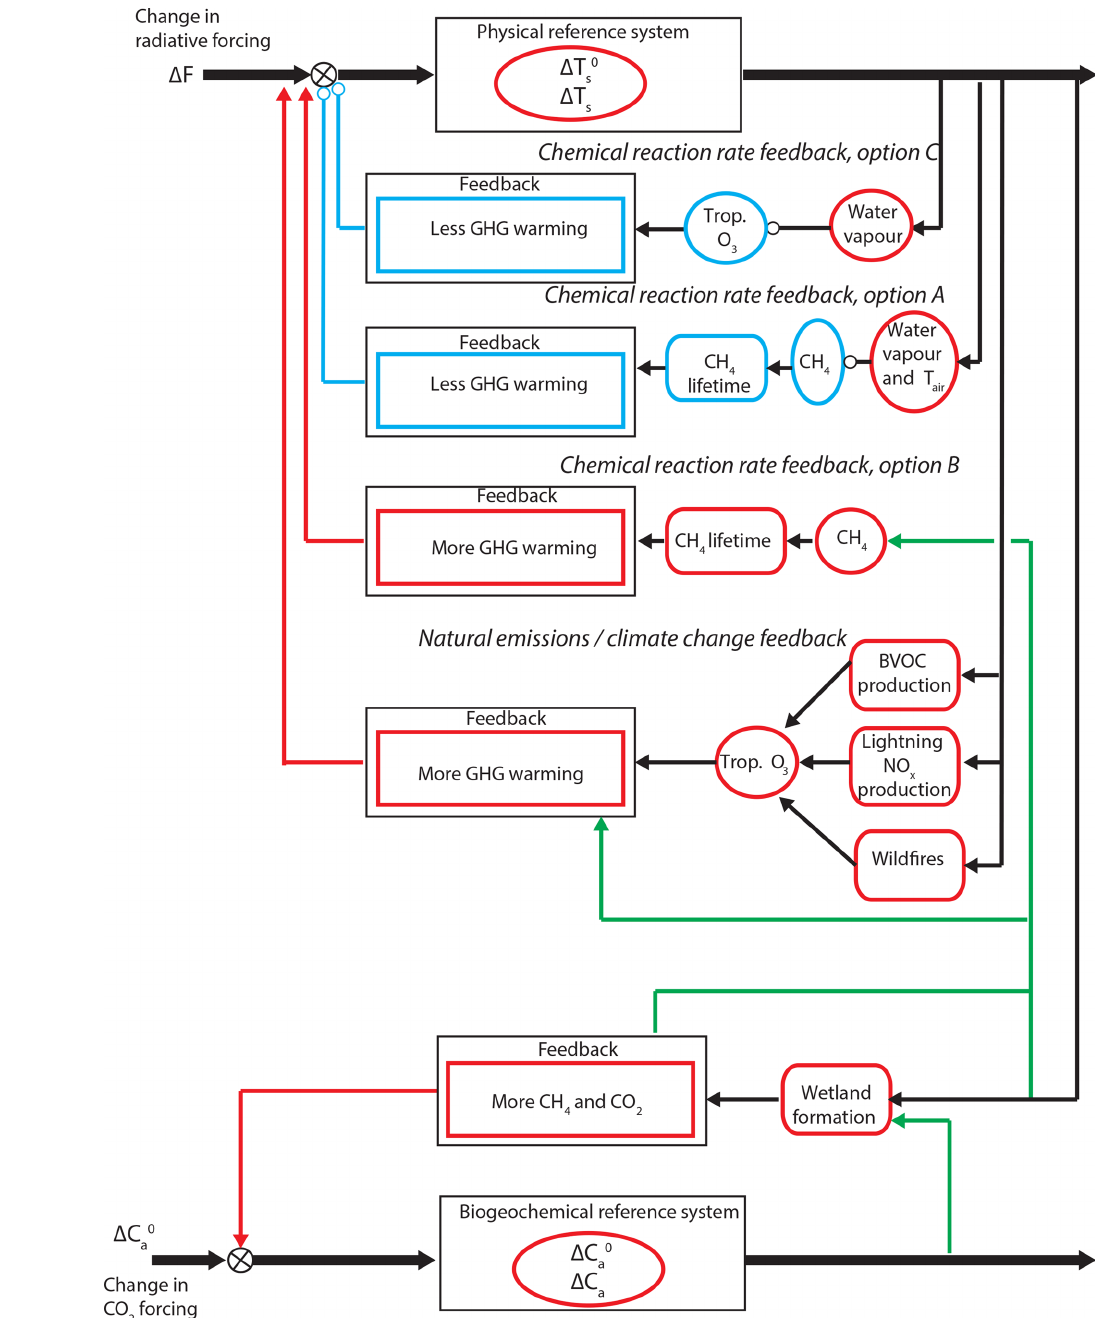
Figure 15. Schematic of important tropospheric chemistry feedbacks. Arrows indicate positive coupling; open circles indicate negative coupling. Changes in state variables are indicated by ellipses, changes in processes by rounded rectangles. Red indicates increasing values of variables, strengthening of processes, or positive feedbacks; blue indicates the opposite. Green arrows and lines indicate couplings of biogeochemical processes to physical processes. The change in surface air temperature (cid:49)T s in the presence of feedback is different from the change (cid:49)T 0 s without feedback. The change in greenhouse gas concentration (cid:49)C a in the presence of a biogeochemical feedback is different from that without this feedback ( (cid:49)C 0 a